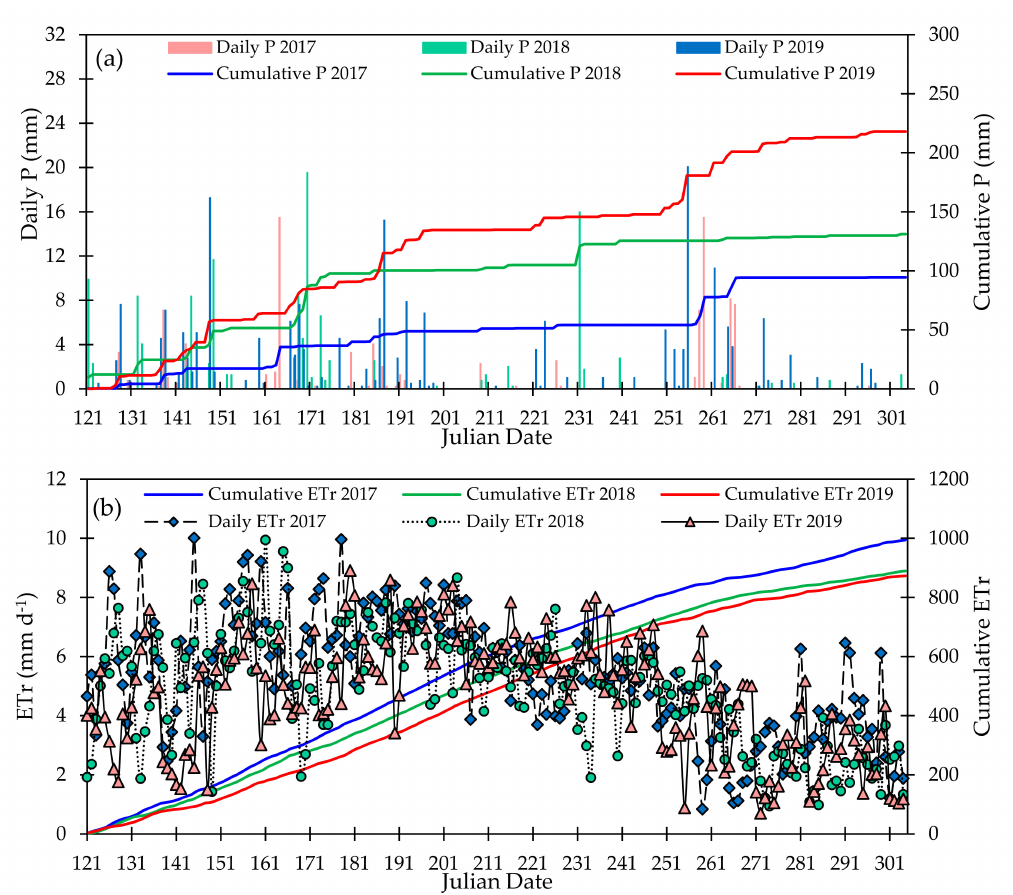
Figure 5. Daily and cumulative seasonal (May to September) ( a ) precipitation (P) and ( b ) reference evapotranspiration (ETr) during 2017, 2018, and 2019 at Powell Research and Extension Center, Powell,